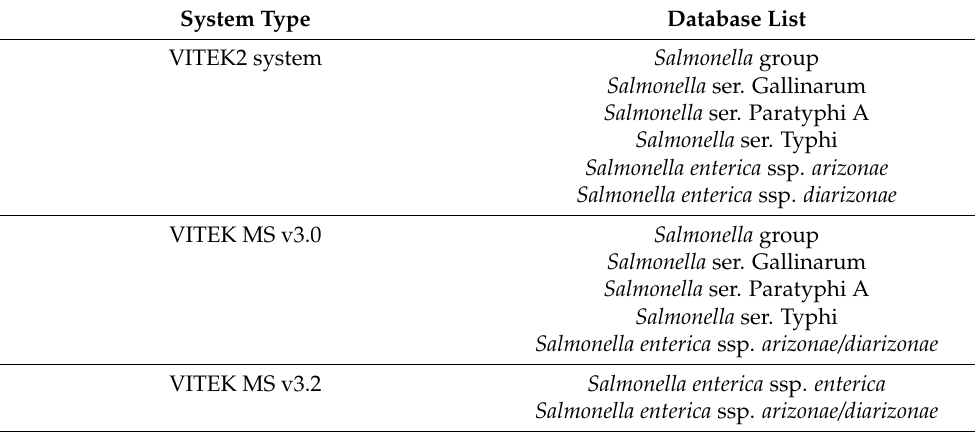
Table 1. Database of VITEK MS v3.0, v3.2, and VITEK2 system for Salmonella